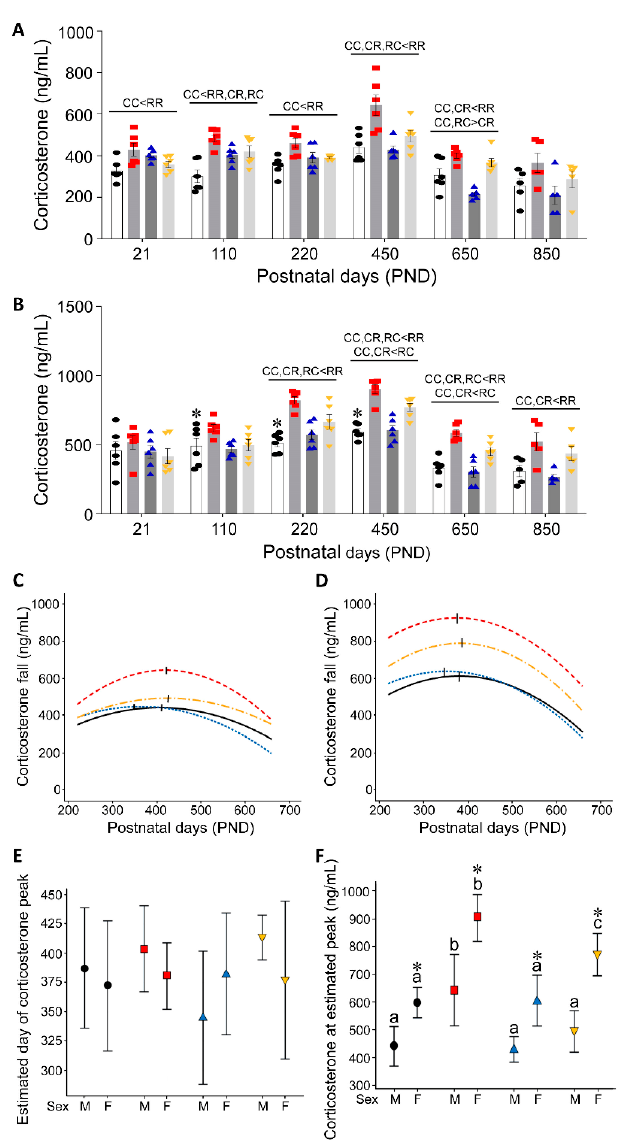
Figure 2. Serum corticosterone in ( A ) male and ( B ) female: histograms averaged data, individual animal data: CC (open histograms, black circles), RR (grey histogram, red squares), CR (grey histogram, blue triangles) and RC (light-grey histogram, yellow inverted triangles) at six life course stages. Data are mean ± SEM, all groups n = 6 except PND 850, n = 5. Differences between the groups of the same sex are indicated on the lines above each age ( p < 0.05). * p < 0.05 male vs. female in C groups at the same age. ( C ) male and ( D ) female show best fit quadratic curves for the corticosterone fall in each group: CC solid black, RR red dash, CR blue dash and RC yellow dash line (PND 220, 450 and 650). ( E ). The male and female estimated days of corticosterone peaks were similar in all groups. ( F ) . Female corticosterone concentrations were higher than males in all groups (* p < 0.05).